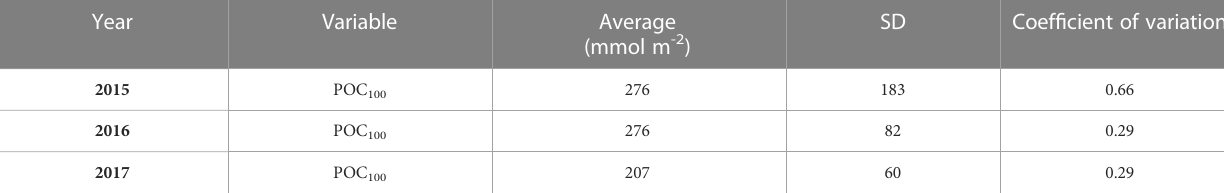
TABLE 3 Integrated POC 100 during three cruises covering the southern Gulf of Mexico ’ s deep-water